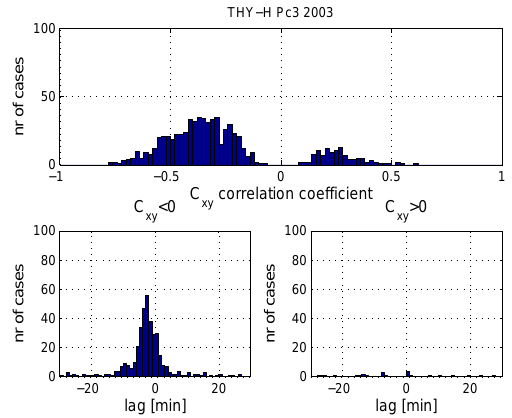
Figure 1. Correlation between Pc3 ind and cone angle for 2003. The top panel shows the number of cases binned by correlation coef- ficient. The bottom panels show the number of cases for positive (bottom right) and negative (bottom left) correlations.